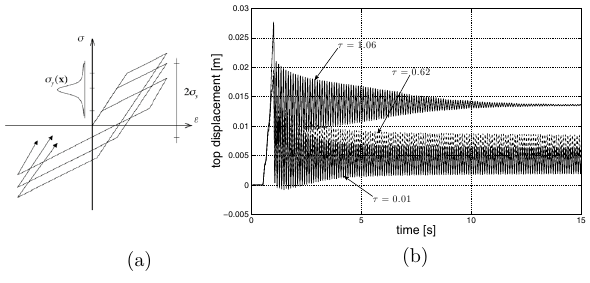
Fig. 28 Simple problem to illustrate stochastic upscaling in dynam- ical system: a Gaussian probability distribution of yield stress 𝜎 y as random variable with 𝜏 as standard deviation; b amplitude decay computed with the proposed multi-scale model, indicating transi- tion from linear amplitude decay for homogeneous structure (bot- tom graph with 𝜏 = 0.01) towards exponential amplitude decay for heterogeneous structure (top graph with 𝜏 = 1.06), adapting energy dissipation to structure size, with more likely heterogenei- ties for larger structures